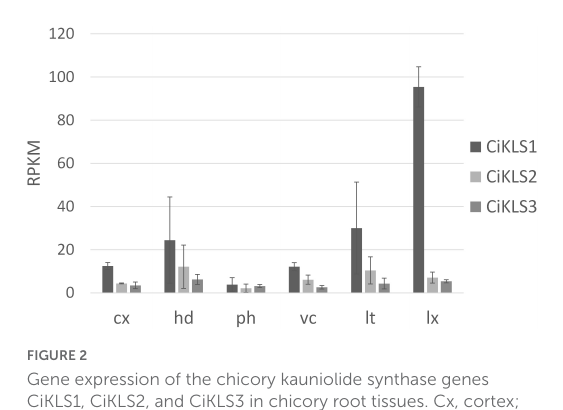
FIGURE2 Gene expression of the chicory kauniolide synthase genes CiKLS1, CiKLS2, and CiKLS3 in chicory root tissues. Cx, cortex; hd, hypodermis; ph, phloem; vc, vascular cylinder; lt, laticifer; lx, latex; RPKM, Reads per kilo base per million mapped reads. Mean and standard deviation for three biological replicates are